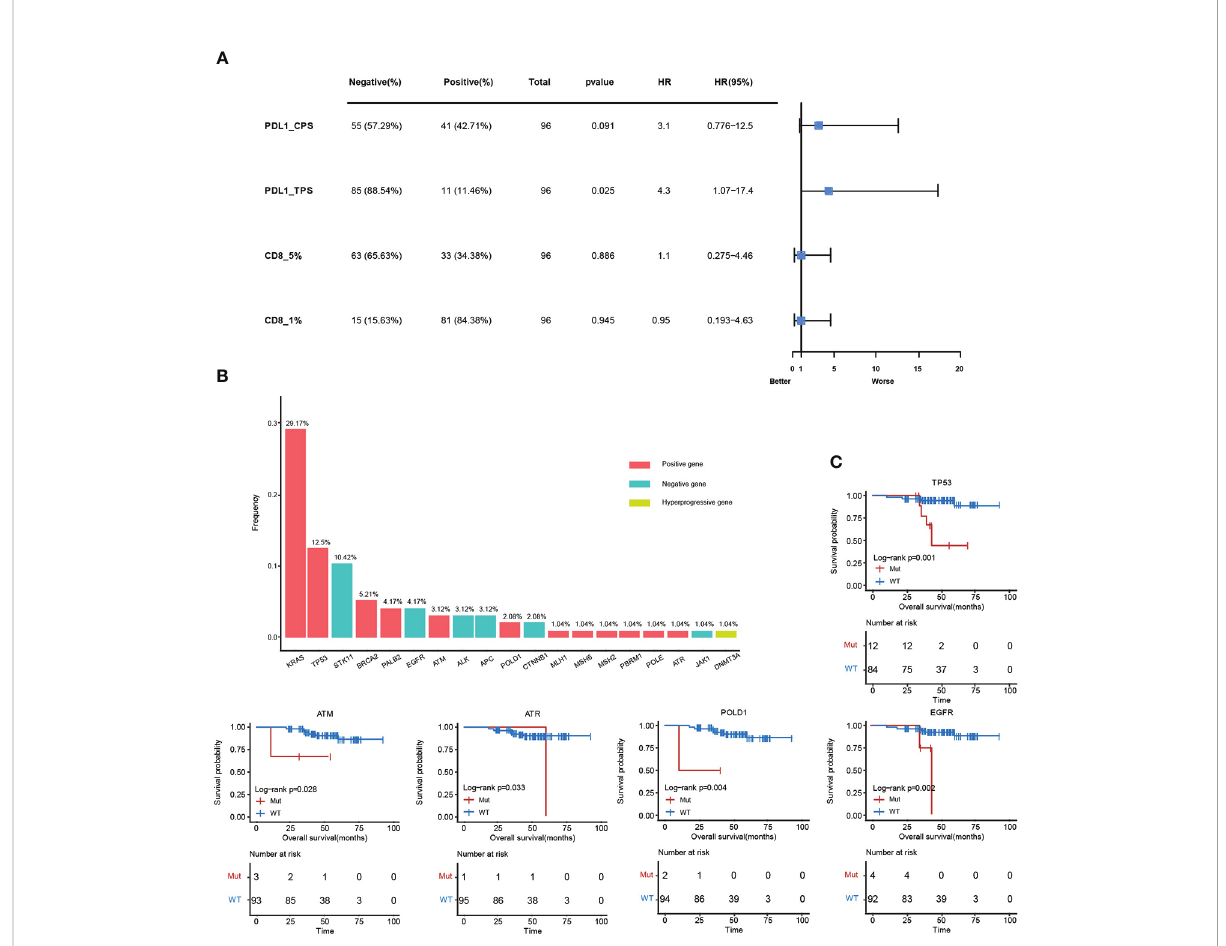
FIGURE 6 Clinical analysis of immune-related mutant genes. (A) , Survival analysis between positive and negative samples in the four immune indicators, PDL1-CPS, PDL1-TPS, CD8 (threshold is 5%), CD8 (threshold is 1%). (B) , The mutation frequency of immune-related genes. The red histograms are immune positively related genes, blue are immune negatively related genes, and yellow are immune hyper-progressive genes. (C) , Survival analysis results between mutant and wild-type immune-related